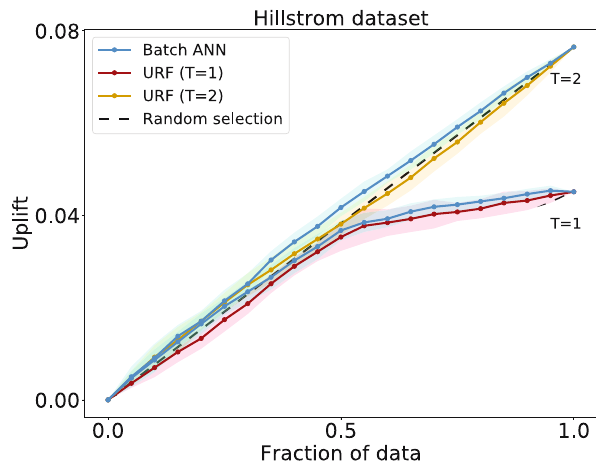
Figure 5: Qini performance on Hillstrom data. Using the Hillstrom dataset ( with k 10 = - fold validation ) , we compare a single batch constrained ANN against two separate URFs, where URF ( T 1 = ) was trained for treatment T 1 = ; and URF ( T 2 = ) was trained for T 2 = . We fi nd our model to outperform both URFs